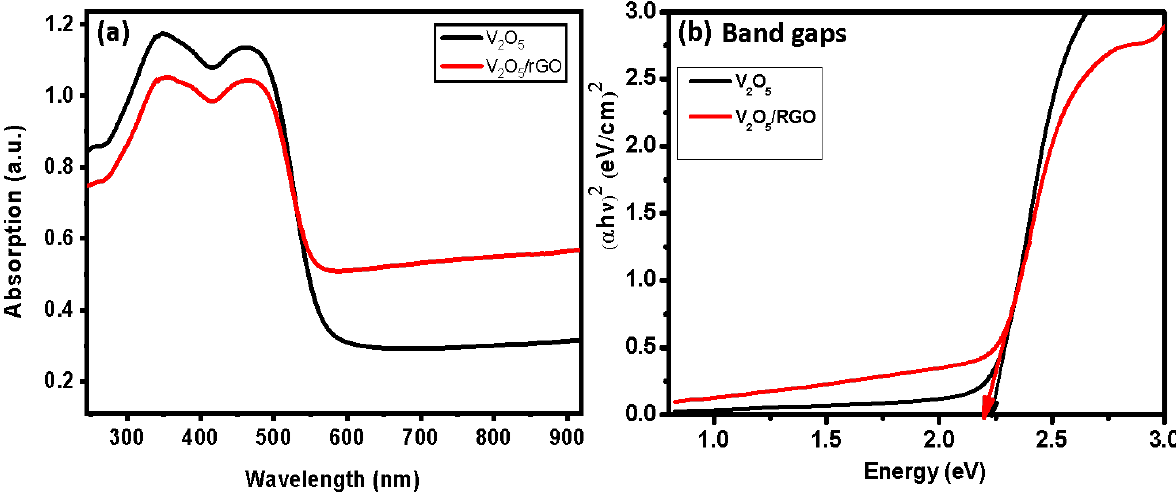
Figure 6. ( a ) UV-Vis absorbance spectra and ( b ) band gap plots of V 2 O 5 and V 2 O 5 /RGO composite.